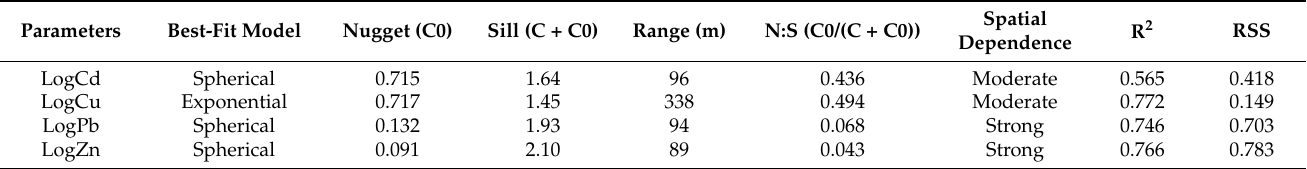
Table 5. Semi-variogram parameters of optimal geostatistical models.